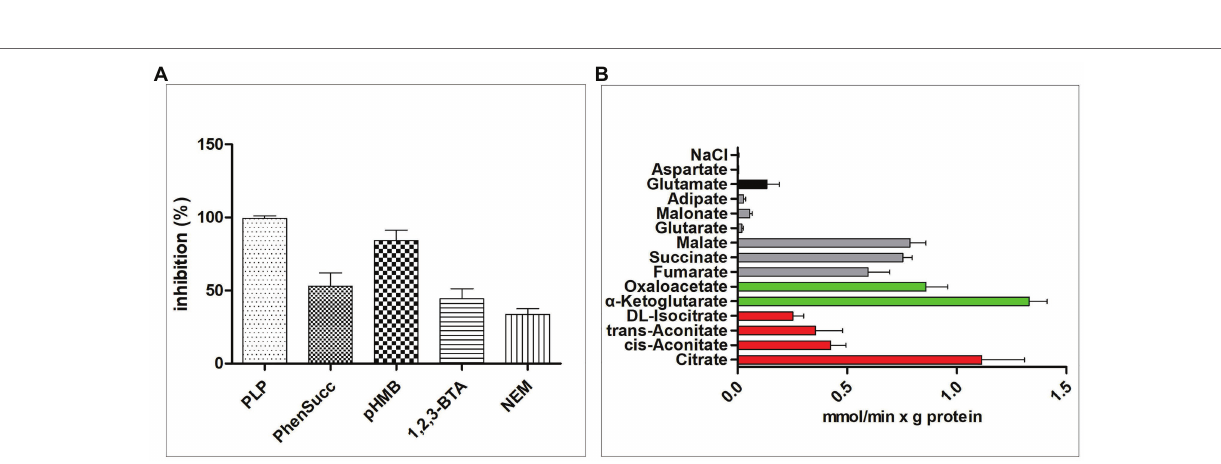
FIGURE 4 | Transport properties of recombinant CT. (A) Effect of inhibitors on the citrate/citrate exchange by CT. Liposomes were reconstituted with CT and preloaded internally with 10 mM citrate. Transport was initiated by adding 0.01 mM [ 14 C]citrate and terminated after 2 min. The concentrations of the inhibitors were 20 mM (PLP, pyridoxal 5 ' -phosphate), 2 mM (phesucc, phenylsuccinate), 0.1 mM (pHMB, p -hydroxymercuribenzoate), 2 mM (1,2,3-BTA, 1,2,3-benzenetricarboxylate), 1 mM (NEM, N -ethylmaleimide). (B) Dependence of CT transport activity on the internal substrate. Reconstructed liposomes containing CT were preloaded internally with a variety of substrates (20 mM). Transport was initiated by adding 0.01 mM [ 14 C]citrate and terminated after 1 min. The values are means ± SEM of at least three independent experiments in duplicate for each internal substrate investigated. Red: tricarboxylic acids. Green color: α -ketodicarboxylic acids. Gray color: dicarboxylic acids. Black color: other compounds. Error bars represent SDs ( n = 3).